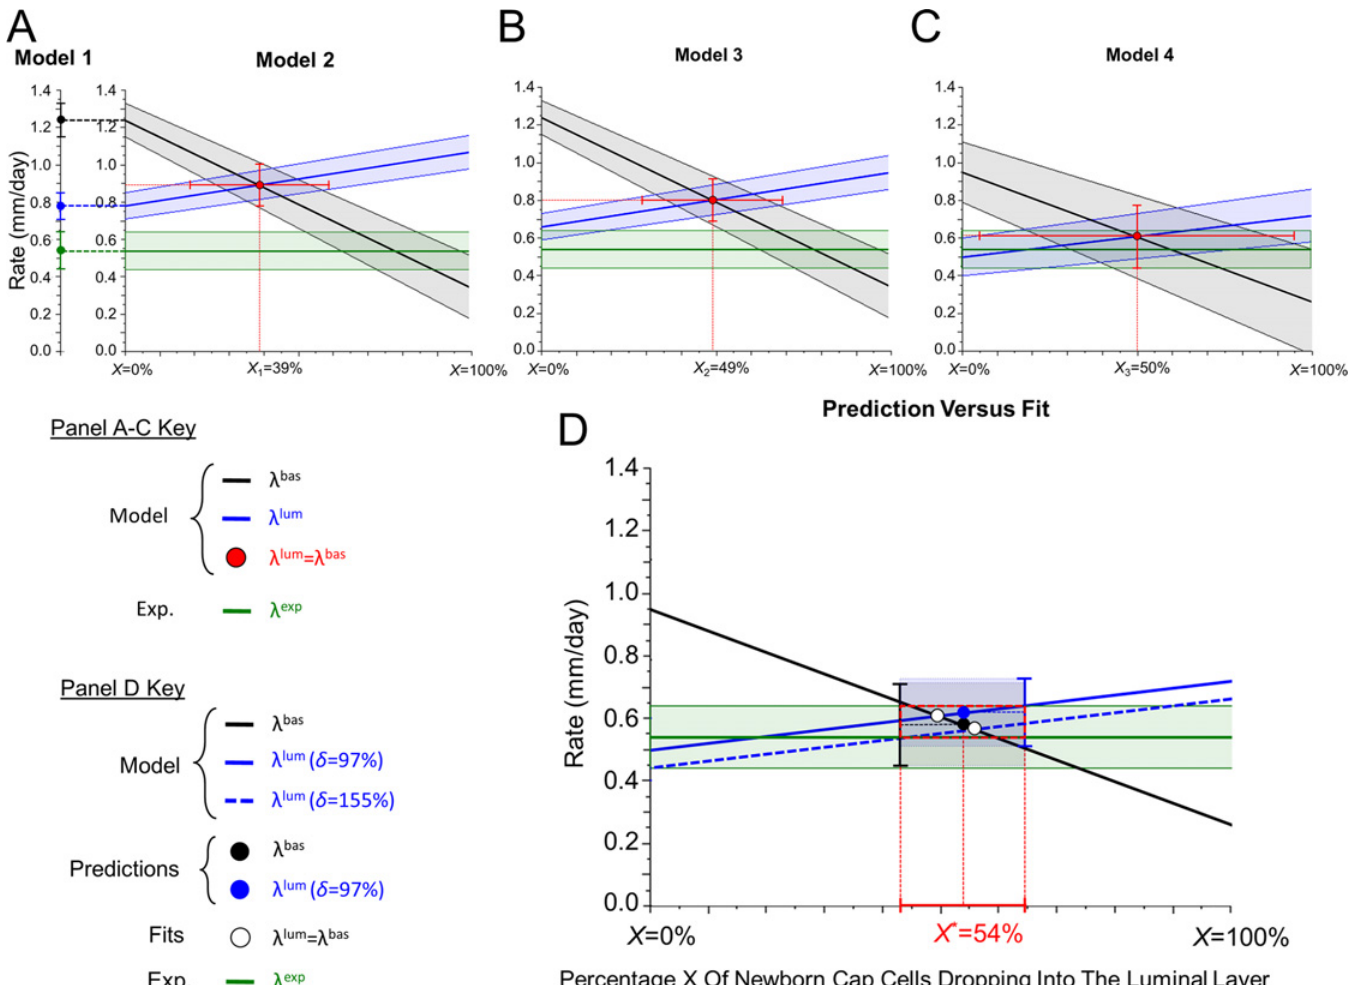
Fig 7. Model iteration summary and fit versus data-informed results. Comparisons between mathematically derived cap cell flux values and values provided by the basal and luminal elongation rates matching condition in the context of the apoptotic correction factor. For each panel green lines represent the experimentally measured rate, black lines represent basal elongation predicted rates and blue lines represent luminal predicted rates. Each bold prediction line is shaded with standard deviation (experimental value) or uncertainty values (model predictions). Model 1 is the “ base model ” . Model 2 is the “ base model + cap cell flux ” . Model 3 is the “ base model + cap cell flux + apoptotic correction ” . Model 4 is the “ base model +cap cell flux +apoptotic correction + displacement conversion ” . A) Model 1 and 2 outputs are shown. Model 1 predicts two separate rates (no cap cell flux, i.e. X = 0%) that both lie outside the experimental dispersion, whereas Model 2 rates predict coordinated growth (for cap cell flux value X 1 = 39%) but a prediction (in red) outside the experimental value error. B) Results from Model 3 which included the required apoptotic correction factor ( δ = 0.97) for the luminal layer are shown. Matching condition yields a cap cell flux value of 49% ( X 2 = 49%) however the predicted rate (in red) still lies outside the experimental dispersion. C) Results from Model 4 are shown after the rates are converted to a displacement rate and δ = 0.97. Matching condition yields a cap cell flux of 50% ( X 3 = 50%) and the predicted rate (in red) lies within the experimental value. D) A summary of the final model predictions and experimentally measured values are shown. Matching condition values (white dots for minimal value δ = 0.97 and for value δ = 1.55 corresponding to Humphreys et al) and experimentally based model prediction (blue and black dots corresponding to X * = 54%) cluster in a small range of admissible values compatible with the experimentally measured rate.